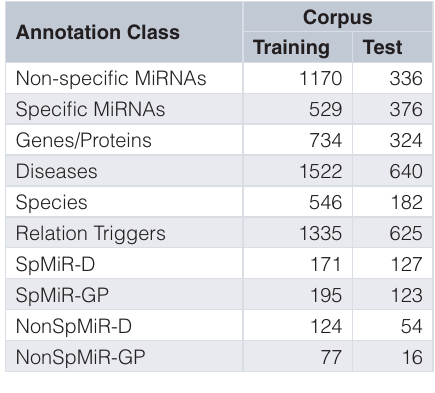
Table 2. Manually annotated entities statistics. Counts of manually annotated entities in the training and the test corpora as well as annotated sentences describing relations.